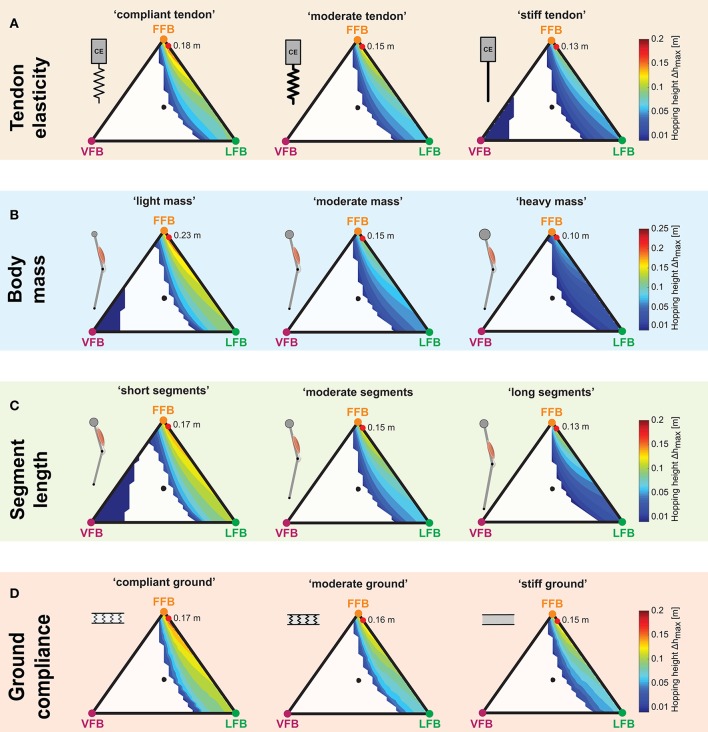
Influence of parameter variations on performance maps: Maximum hopping height (Δhmax) for blended feedback signals (y0 = 1.05 m,G = 1, PreStim = 0.01). Global maxima are visualized by red points. Every point within the triangle represents a unique combination of the three feedback pathways. The larger the distance of a point to a corner (e.g., LFB) the smaller the contribution of that feedback pathway in the blended signal (see Figure 3 for explanation of triangles). (A) Tendon elasticity changes: “compliant tendon” (εcompliant = 0.05), “moderate tendon” (εmoderate = 0.03), “stiff tendon” (εstiff = 0.01); (B) body mass changes: “light mass” (mlight = 64 kg), “moderate mass” (mmoderate = 80 kg), “heavy mass” (mheavy = 96 kg); (C) segment length changes: “short segments” (lS,short = 0.4 m), “moderate segments” (lS,moderate = 0.5 m), “long segments” (lS,long = 0.6 m); and (D) ground compliance changes: “compliant ground” (kcompliant = 100 kN/m), “moderate ground” (kmoderate = 500 kN/m), “stiff ground” (kstiff = 9, 999 kN/m).